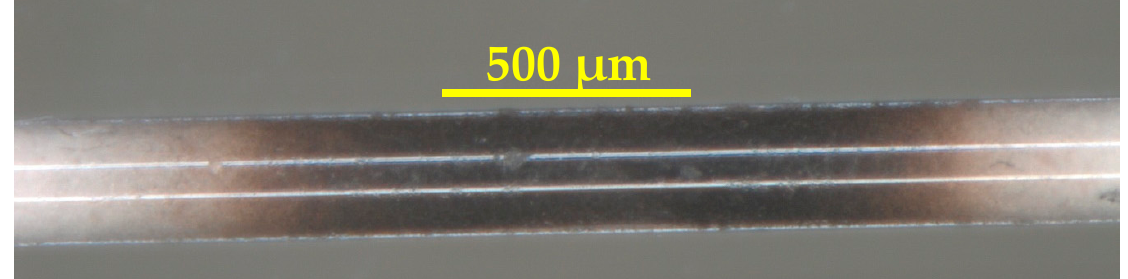
Figure 4. Glass capillary with 0.3 mm outer diameter filled with SbC 2 O 4 OH after exposure to synchrotron radiation ( λ = 112.684(1) pm) for 1 h; the darkened area in the middle was exposed to the beam and probably contains amorphous carbon from the decomposition by radiation damage.